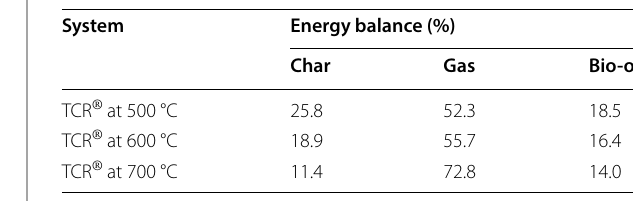
Table 7 Energy balance of products from spent coffee grounds through TCR ®